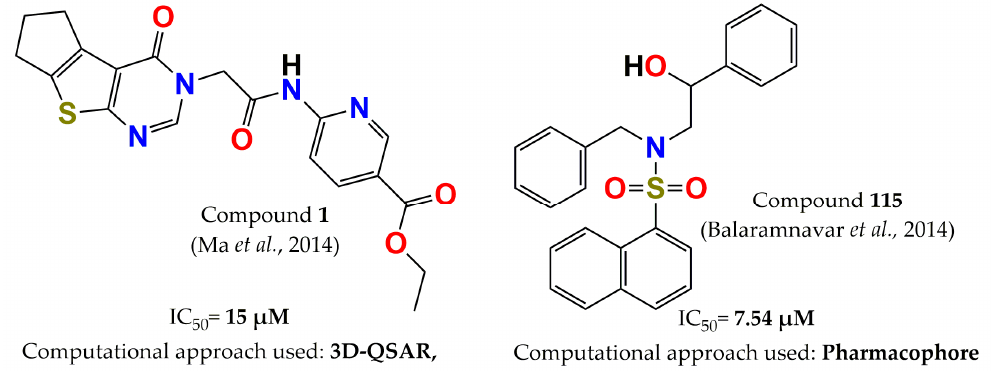
Figure 7. Structure of the most potent PTP1B inhibitors reported in 2014 discovered through computational approaches.